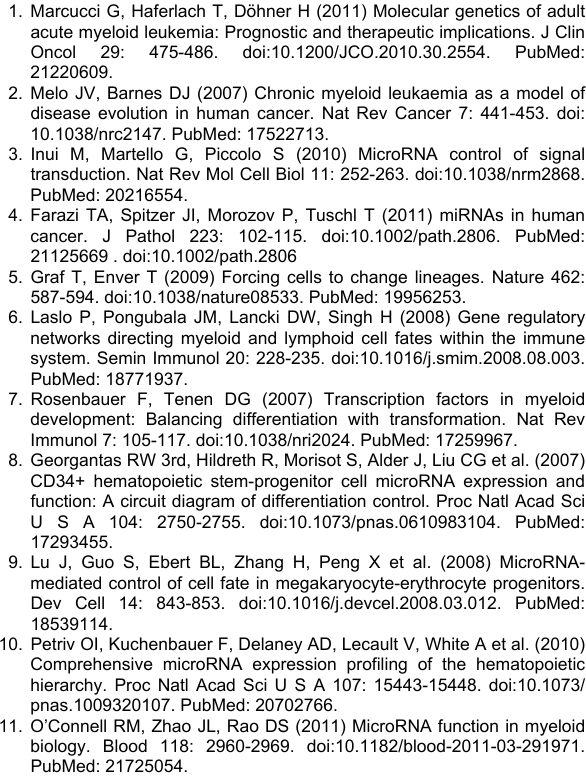
Table S5. IPA Upstream Regulator Analysis was used to identify putative upstream regulators that were activated (or inhibited) in the gene expression data for PL21, HL60, and THP1 cells. IPA Upstream Regulator Analysis was